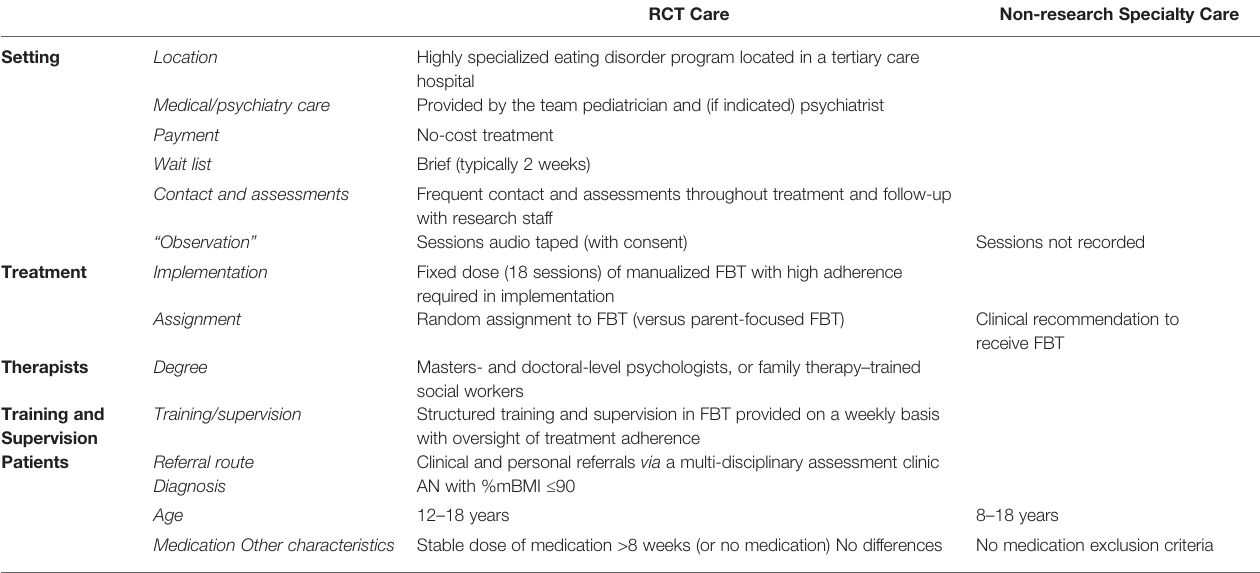
TABLE 1 | RCT Care vs. Non-research Specialty